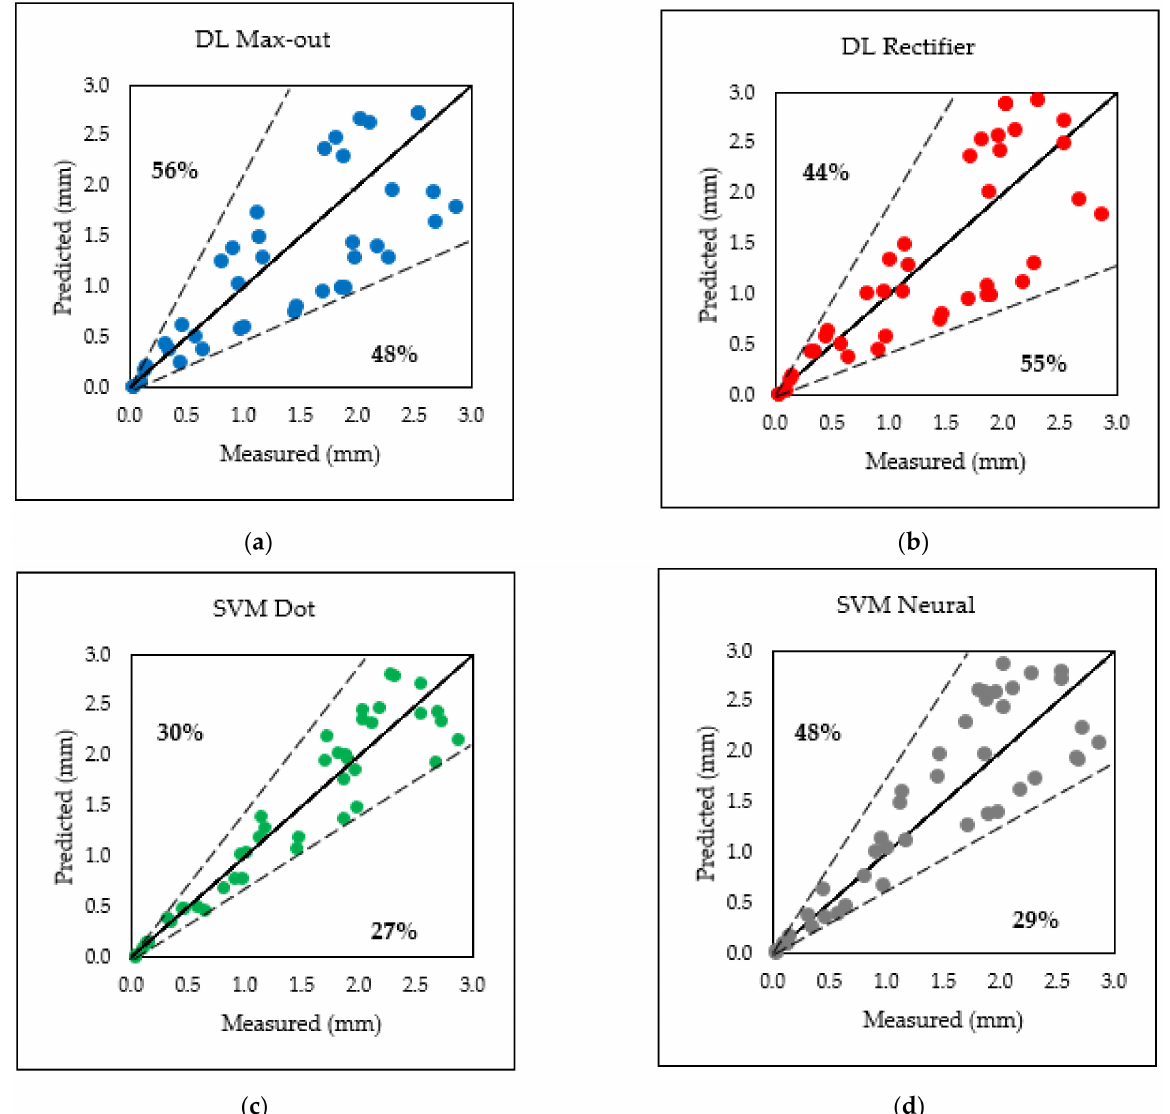
Figure 10. The distribution of predicted crack width for ( a ) DL Max-out prediction model ( b ) DL Rectifier prediction model ( c ) SVM—dot prediction model and ( d ) SVM—neural prediction